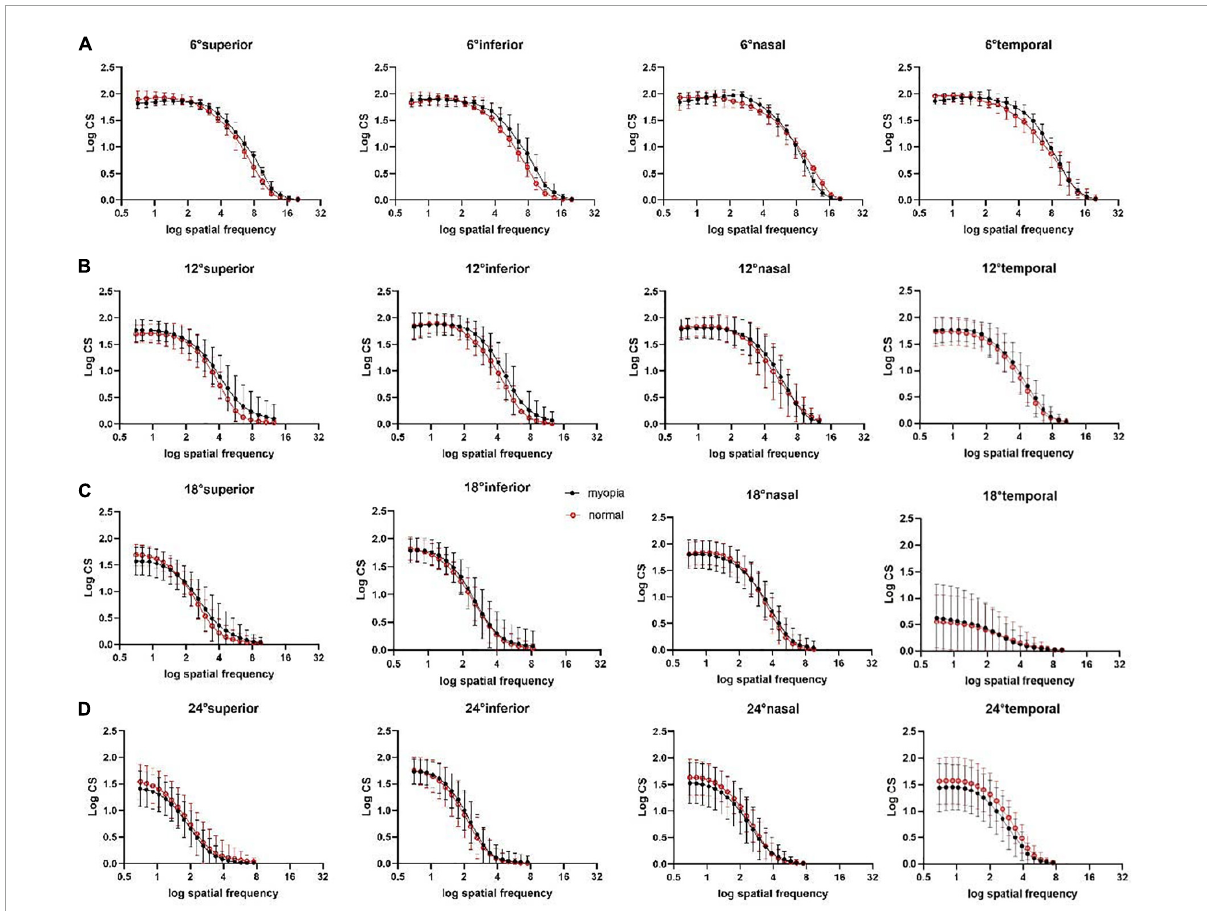
FIGURE4 Peripheral CSFs at superior, inferior, nasal, temporal visual field locations at (A) peripheral 6 ◦ , (B) peripheral 12 ◦ , (C) peripheral 18 ◦ , (D) peripheral 24 ◦ . Each curve represents the fit of second-order polynomials to the average observed CSF. The middle points of the vertical line segments denote the mean log CS values; the top and bottom of the vertical line segments represent the 25th and 75th percentile